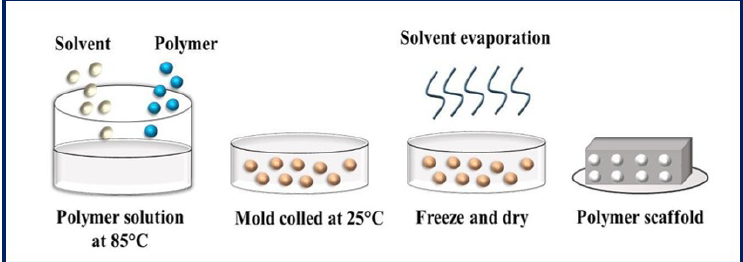
Figure 9. Schematic diagram of solid-liquid phase separation. Bibliography consulted [88].